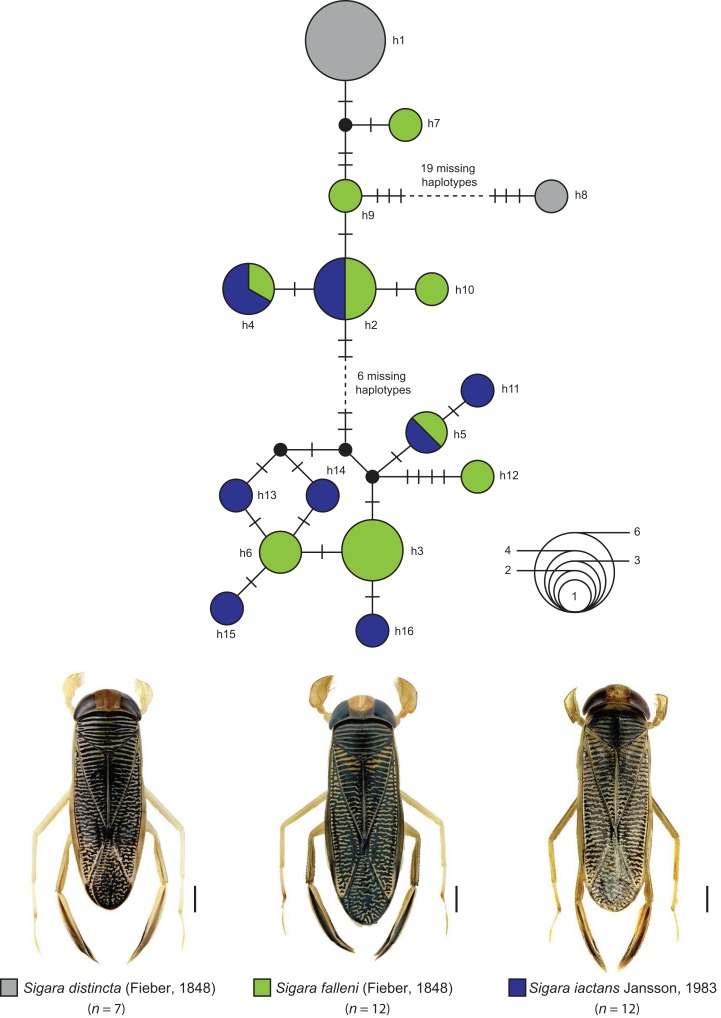
Maximum statistical parsimony network of three Sigara species with interspecific K2P-based distances of COI sequences <1%.Used settings included default settings for connection steps whereas gaps were treated as fifth state. Each line represents a single mutational change whereas small black dots and small black lines indicate missing haplotypes. The diameter of the circles is proportional to the number of haplotypes sampled (see open half circles with numbers). Color codes were given for each species. Scale bars = 1 mm. Aquatic bug images were obtained from http://www.corisa.de.